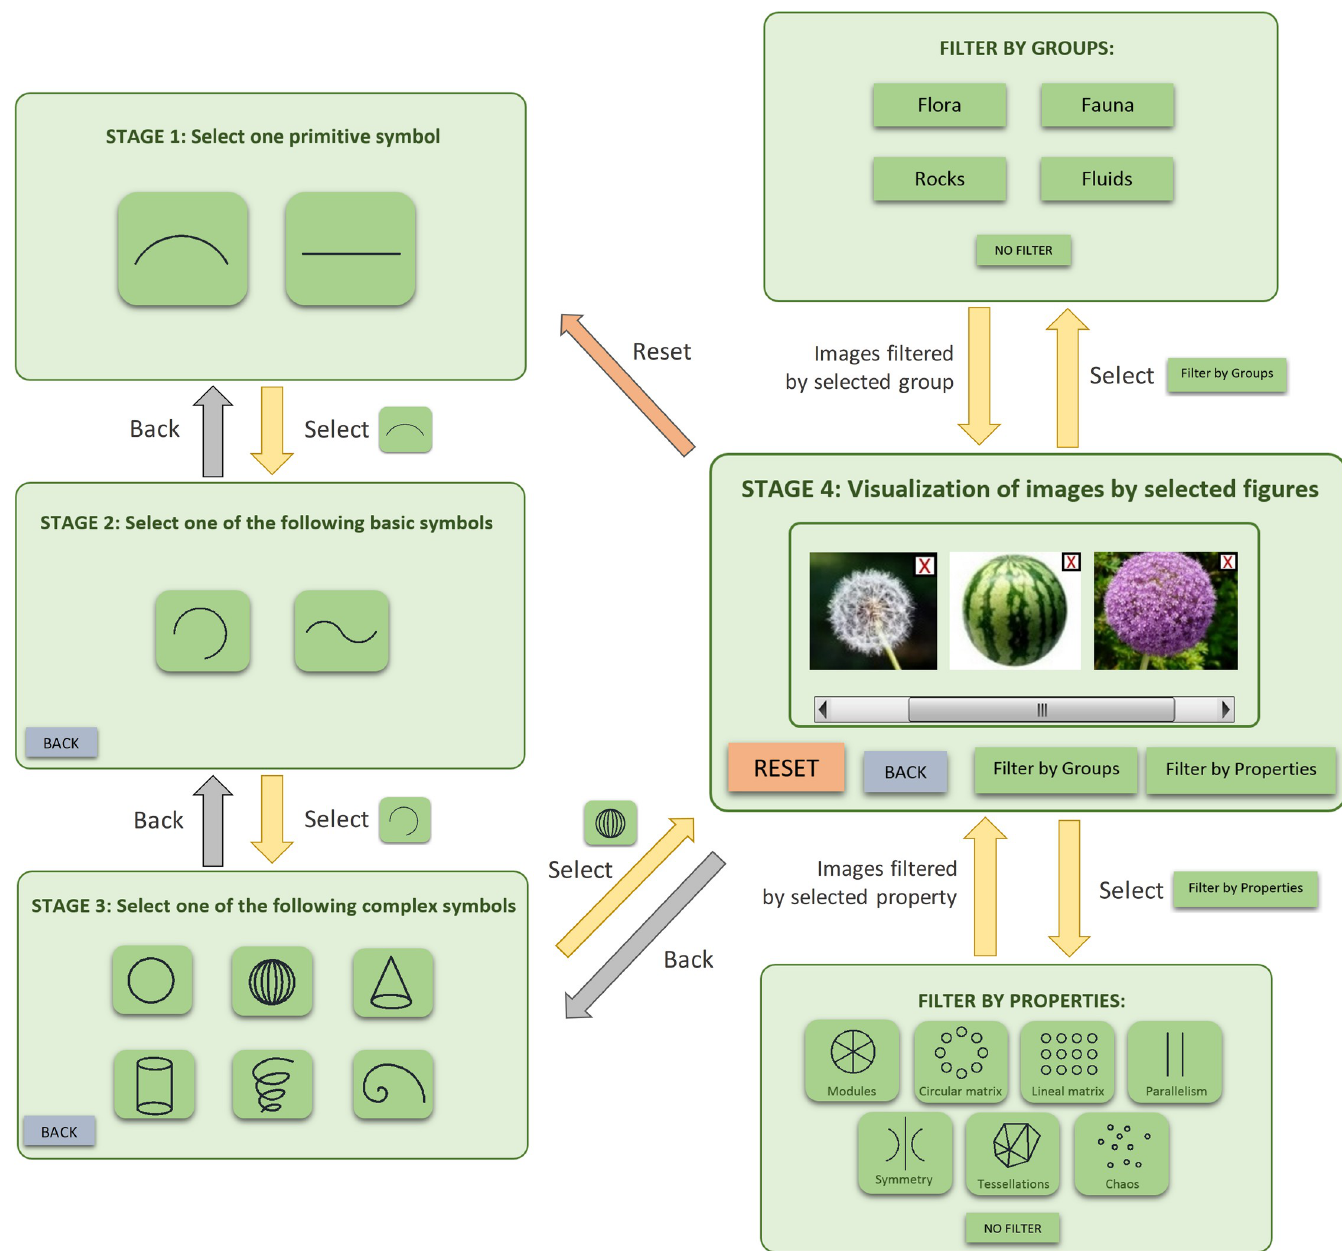
Fig 3. Functioning scheme of the